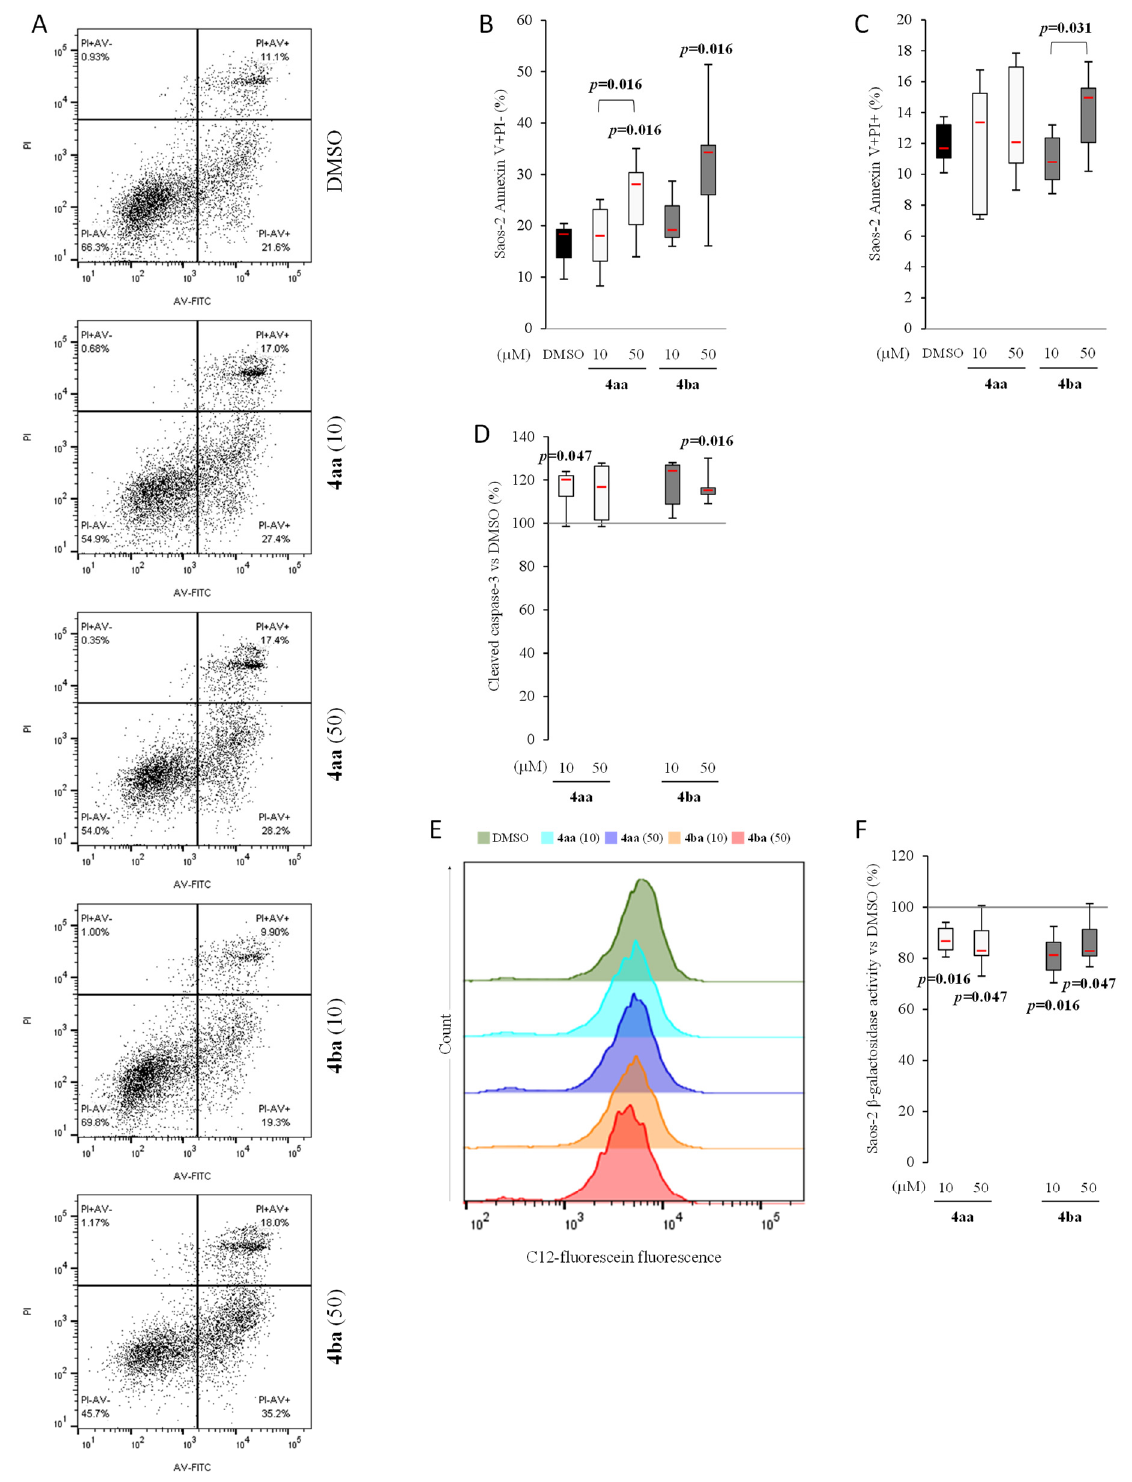
Figure 5. Pyridazinone scaffold-based molecules increase Saos-2 apoptosis and reduce senescence. Representative cytogram of AV and PI stain ( A ). Quantification of early (AV+/PI- cells ( B )) and late apoptosis (AV+/PI+ cells ( C )). Quantification of cleaved caspase-3 versus DMSO ( D ). Representative histograms of intracellular β -galactosidase activity ( E ) and its quantification versus DMSO ( F ). n = 7. p -values are given relative to DMSO on box-plots; the brackets indicate the conditions compared.